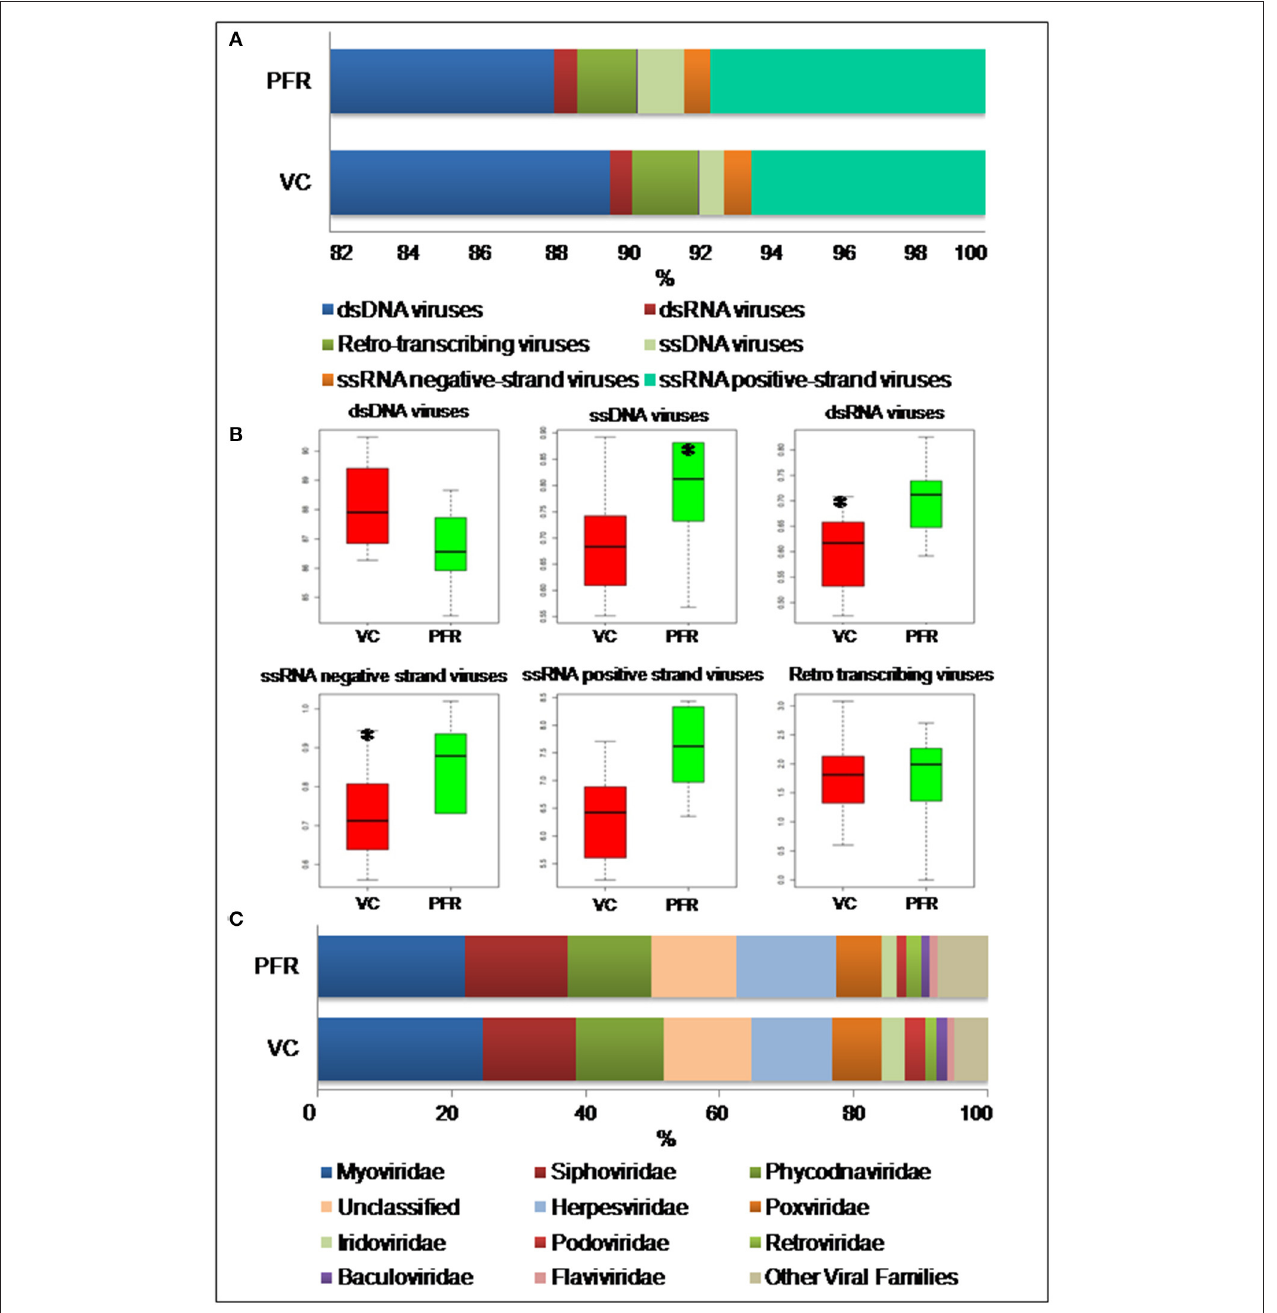
FIGURE 2 | (A) Abundance of different virus groups in the vitreous fluid of control (VC) and post-fever retinitis (PFR) groups. (B) Box plots illustrating the abundance of dsDNA viruses, ssDNA viruses, dsRNA viruses, ssRNA negative-strand viruses, ssRNA positive-strand viruses, and Retro transcribing viruses in the vitreous fluid of control (VC) and post-fever retinitis (PFR) groups. (C) Abundance of Virus families in the vitreous fluid of control (VC) and post-fever retinitis (PFR) groups. *indicates significant change ( p > 0.05).